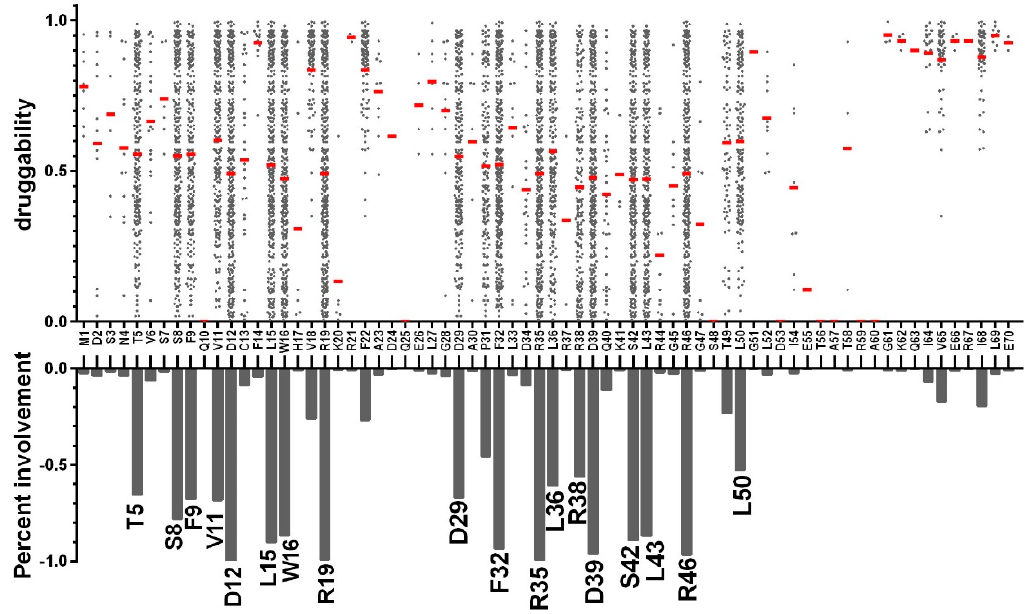
Figure 6. Residues involved in the 323 groove-pockets. For each of the RBD residues, each dot in the upper graph depicts one groove-pocket in which it is involved, with its druggability score (y-scale); the mean bar (red) represents the average druggability score of all the pockets in which a given residue is involved. The lower graph shows the percentage of groove-pockets in which each residue is involved.